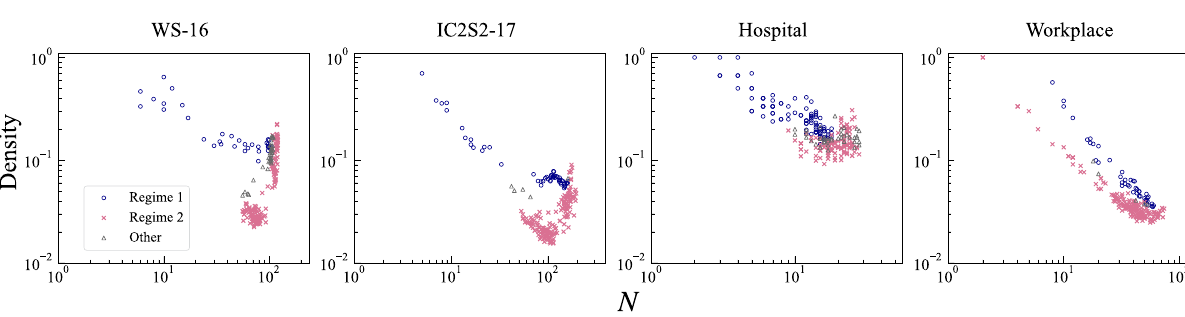
Figure 5. Estimation of N p, t and κ t for ( a ) Hospital and ( b ) Workplace.